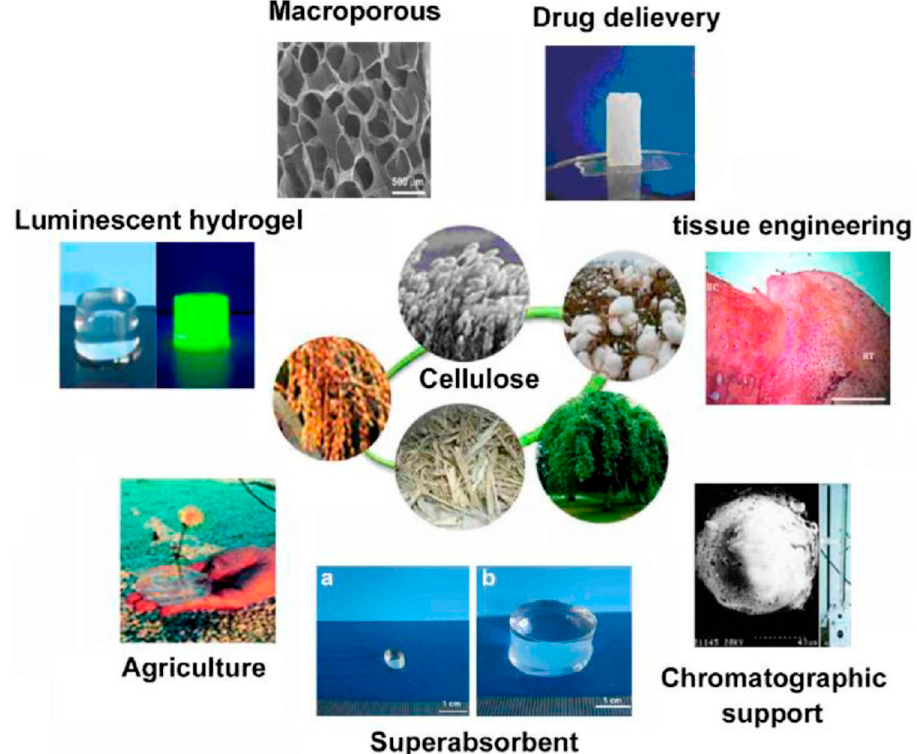
Figure 2. Application and development of cellulose-based hydrogel. The figure above was adapted with permission from the cited reference